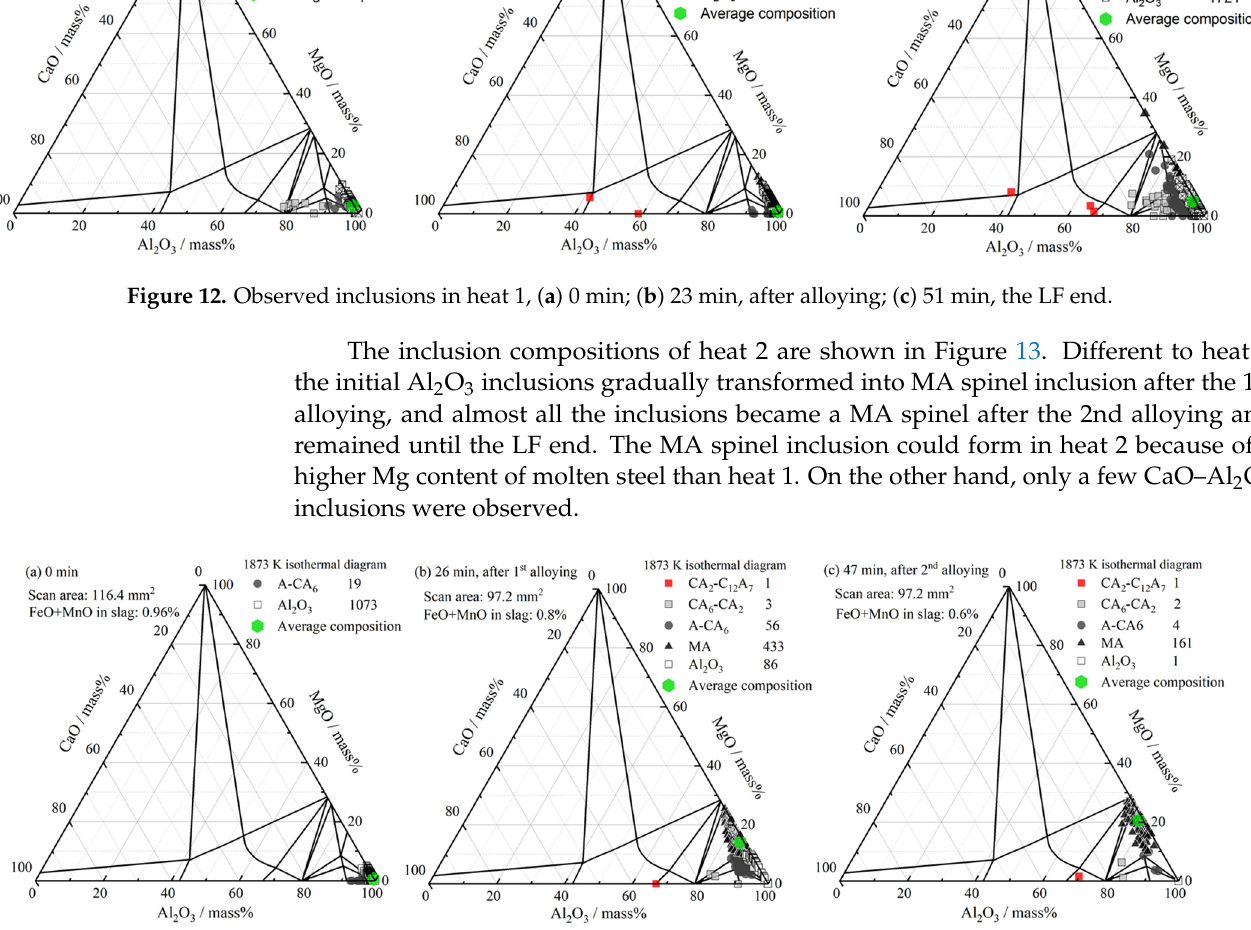
Figure 13. Observed inclusions in heat 2 at ( a ) 0 min, ( b ) 26 min after the 1st alloying, and ( c ) 51 min after the 2nd alloying.